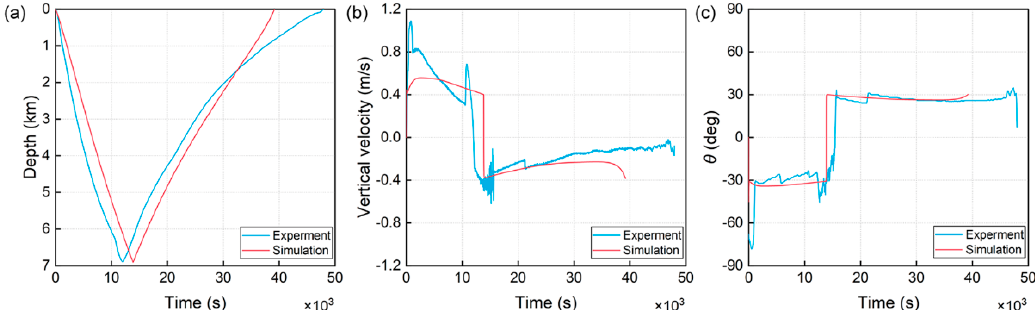
Figure 20. Experimental results and simulation comparison of the LR mode: ( a ) Depth vs. time; ( b ) Vertical velocity vs. time; ( c ) θ vs. time.